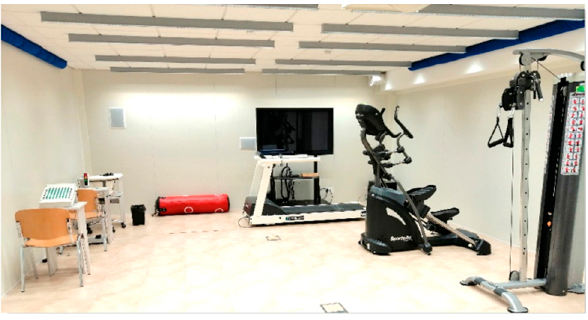
Figure 2. A view on the laboratory room.